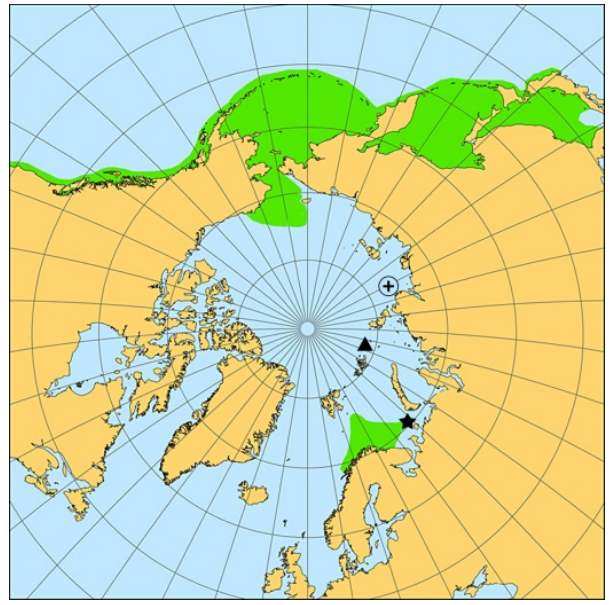
Figure 1. Map of walleye pollock Gadus chalcogrammus range (green shading) and its new records in the Barents Sea ( (cid:70) ), Kara Sea ( ▲ ), and Laptev Sea ( ⊕ ). All biological work was carried out in accordance with generally accepted meth- ods [32,33]. In all fish, the total length ( TL ) and body weight were measured. In individuals from the Barents and Kara seas, the sex, the stages of gonad maturity, the weight of the liver, gonads, and stomach contents were additionally determined, and the age was examined by sagittal otoliths. Sagittae were extracted from freshly caught fish during the biological analyses onboard. The age determinations were carried out in the laboratory. Sagittae were broken transversely in half with a lancet and baked, then polished if necessary. They were burned in the flame of an alcohol burner. For the preparation of polished cross- sections of the sagittae, abrasive discs with aluminum-oxide- or silicon-carbide-coated grit of 0.1 − 0.9 µ m (Buehler, Inc., Lake Bluff, IL, USA) were used. The readiness of each sagitta for further analysis was determined individually on the basis of visual observations. We used a trinocular microscope (Olympus SXZ12) with a DFPLAPO 1 × PF lens to view the cross-sections at 1 × 20–40 magnification. Otolith cross-sections were coated with glycerin and illuminated with reflected light [34,35]. The ratio between otolith length and otolith width [36] are based on the measurements made using digital caliper. Gonadal maturity state of walleye pollock specimens were examined at macroscopic level based on a six-stage scale [37]. Four individuals from the Laptev Sea (specimens from the Kara and Barents Seas were discarded after dissection, examination of biological characteristics, and extraction of sagittae) were subjected to morphometric analysis with the measurement of characteristics previously used by various authors in the study of specimens from the North Pacific and the North Atlantic [23,24,28,30,38–41]. The following morphometric characteristics were measured: predorsal and preanal lengths, pectoral and pelvic fin lengths, body depth, depth of caudal peduncle, head length, upper jaw length, interorbital length, horizontal and vertical eye diameters, preorbital and postorbital lengths, lengths of D1 , D2 and D3 bases, lengths of A1 and A2 bases. All measurements were carried out on individuals preserved in a 6% formalin solution using digital calipers. Counts of the number of D1 , D2 , D3 , A1 , A2, pectoral, pelvic, and caudal fin rays, and number of vertebrae were carried out according to radiographs produced on an EcoRay Orange 1040 HF Portable